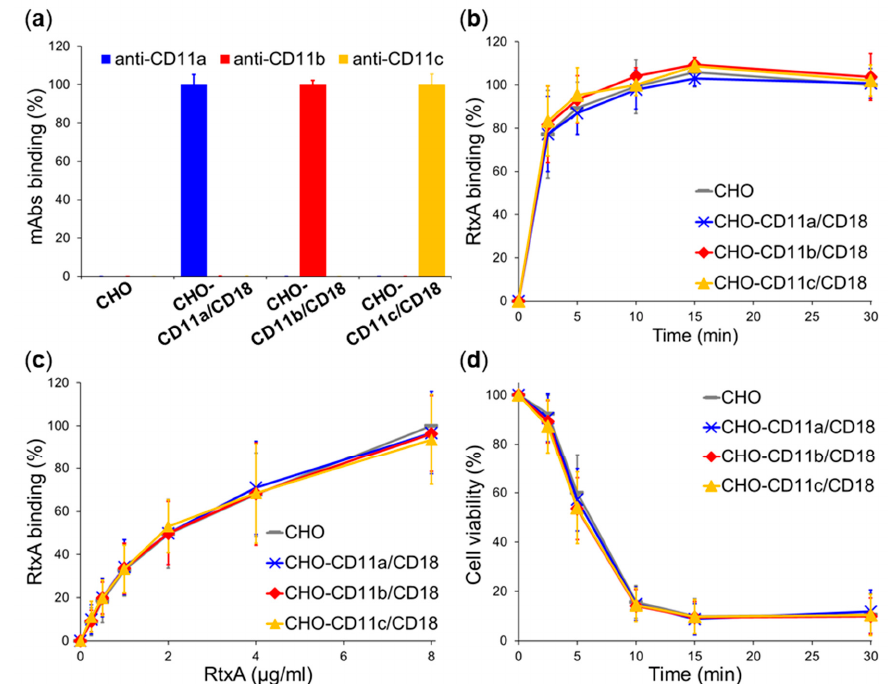
Figure 4. RtxA binds and kills cells expressing β 2 integrins with the same e ffi cacy as cells lacking any β 2 integrin. ( a ) Stably transfected CHO cells expressing the human integrin CD11a / CD18, CD11b / CD18, or CD11c / CD18, or mock-transfected CHO cells expressing no β 2 integrin (1 × 10 6 / mL) were incubated for 30 min at 4 ◦ C with anti-CD11a, anti-CD11b, and anti-CD11c mAbs and analyzed by flow cytometry. Binding data were deduced from the MFI values and the highest MFI value for each mAb was taken as 100%. ( b ) CHO cells expressing β 2 integrin molecules, or no β 2 integrin (1 × 10 6 / mL) were incubated with 2 µ g / mL of the purified and labeled RtxA-Dy495 toxin for di ff erent times at 4 ◦ C and analyzed by flow cytometry. ( c ) CHO cells expressing β 2 integrin molecules, or no β 2 integrin (1 × 10 6 / mL) were incubated with di ff erent concentrations of RtxA-Dy495 for 30 min at 4 ◦ C and analyzed by flow cytometry. ( b , c ) Binding data were deduced from the MFI values and expressed as percentage of RtxA binding to mock-transfected CHO cells at time 30 min ( b ) or at a concentration of 8 µ g / mL ( c ) (taken as 100%). Each point represents the mean value ± SD of four independent experiments. RtxA binding to integrin-expressing cells was at all measured time and concentration points statistically indistinguishable from binding to mock-transfected CHO cells expressing no β 2 integrin ( p -value > 0.05; ANOVA). ( d ) CHO cells expressing β 2 integrin molecules, or no β 2 integrin (1 × 10 6 / mL) were incubated with 0.5 µ g / mL of the purified RtxA toxin for di ff erent times at 37 ◦ C. Cell viability was determined by a cell viability staining assay using 1 µ g / mL of Hoechst 33258 followed by flow cytometry. The viability of cells incubated without RtxA (time 0) was taken as 100%. Each point represents the mean value ± SD of four independent experiments. Upon incubation with RtxA, the viability of β 2 integrin-expressing CHO cells was at all measured time points found to be statistically the same as the viability of CHO cells expressing no β 2 integrin ( p -value > 0.05;